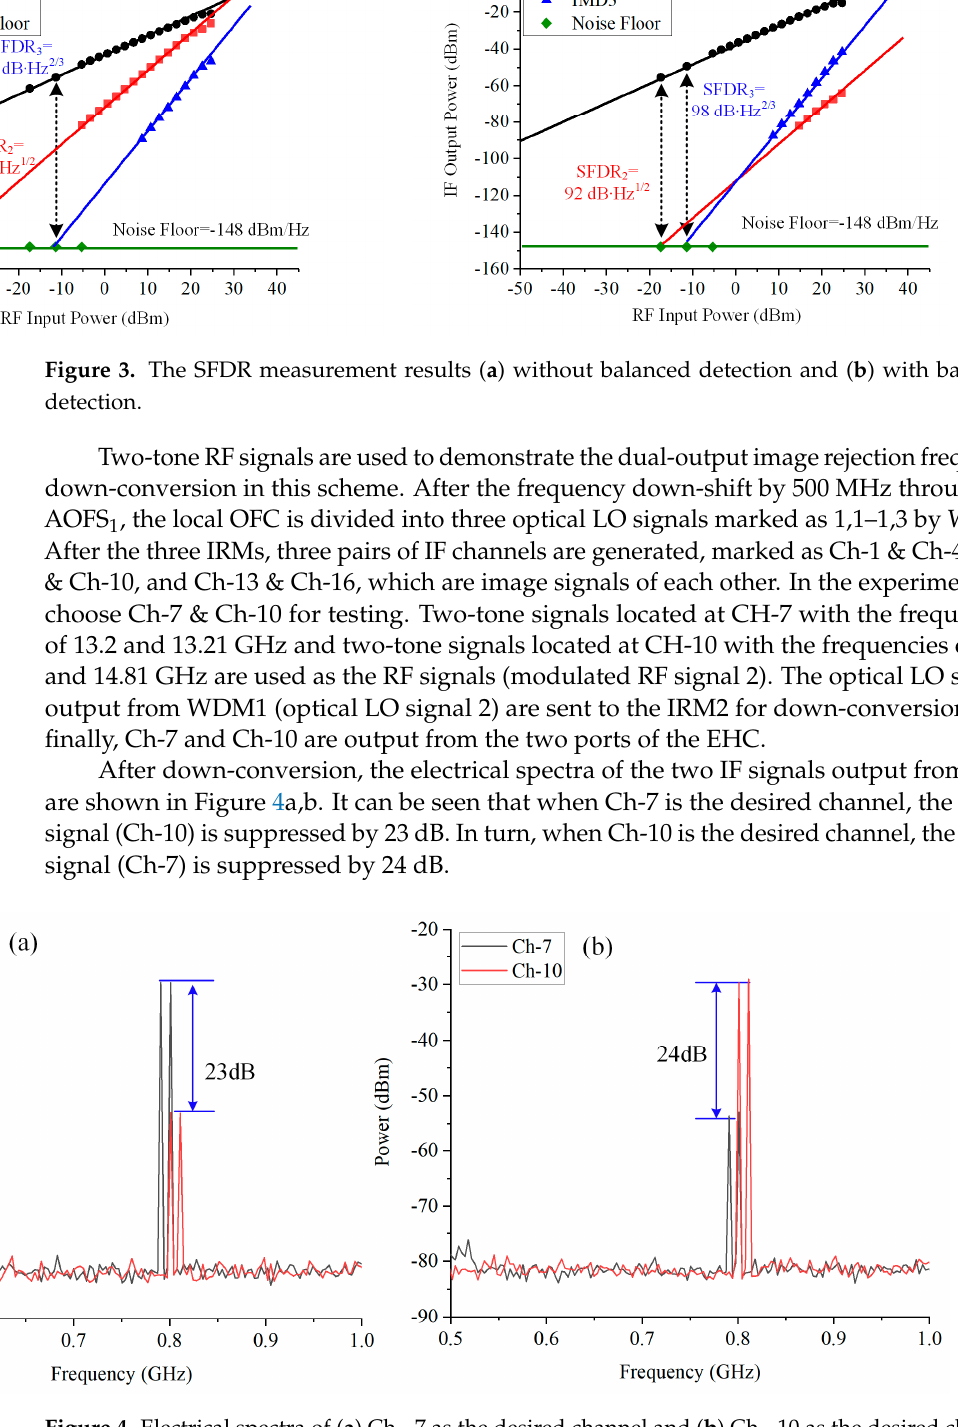
Figure 4. Electrical spectra of ( a ) Ch − 7 as the desired channel and ( b ) Ch − 10 as the desired